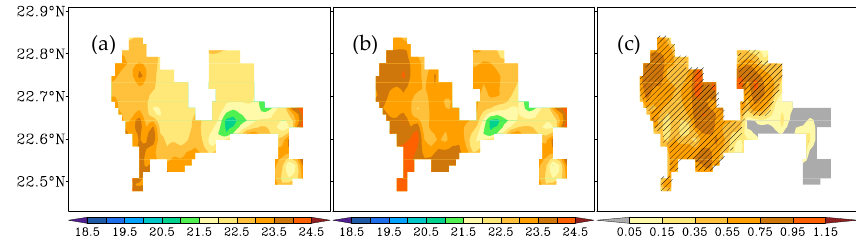
Figure 3. Spatial distributions of ( a , b ) T 4 and ( d , e ) T xn , and ( g , h ) the corresponding differences (T xn minus T 4 ) under ( a , d , g ) EX1 and ( b , e , h ) EX2 for 1980 and 2016. ( c , f ) The 37-year averaged warming for ( c ) T 4 and ( f ) T xn , and ( i ) the corresponding differences over Guangzhou (oblique line denotes passing the 90% confidence level significance t -tests, units: °C).